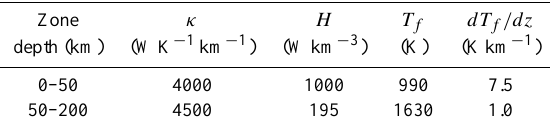
Table B1. Simple earth heat flow model